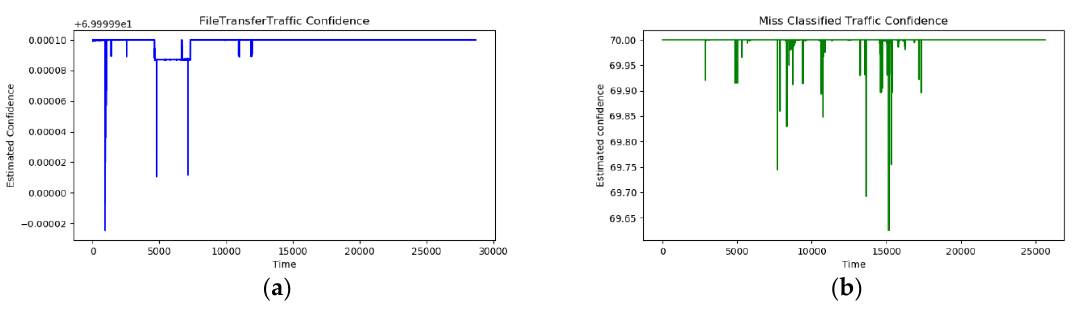
Figure 13. Confidence value trend of packets whose membership level is the maximum for the file transfer type among all data. ( a ) shows the distribution of actual file transfer type data. ( b ) shows the distribution of the misclassified data. Table 4. Accuracy for each traffic type.